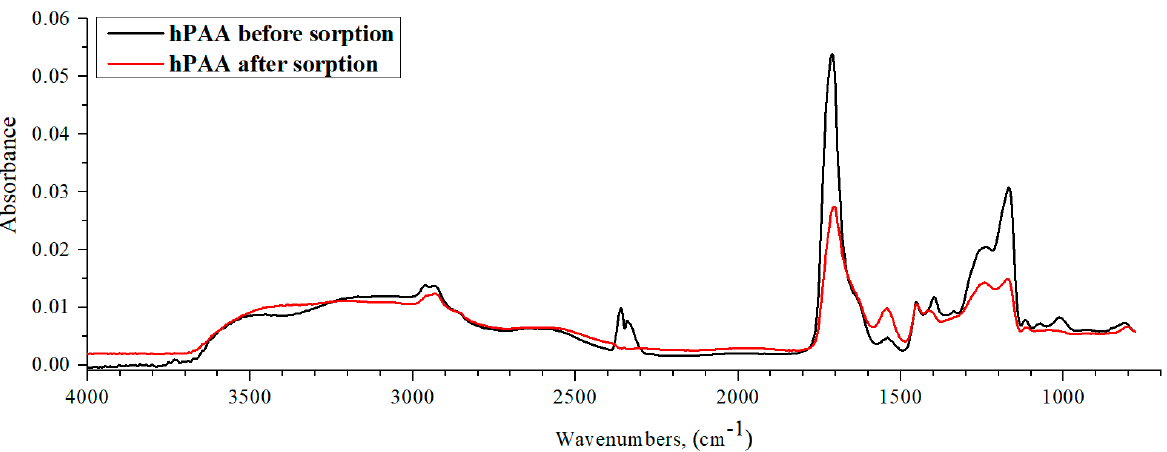
Figure 12. IR spectra of hPAA before and after lanthanum sorption by interpolymer system 67%hPAA-33%hP2M5VP.